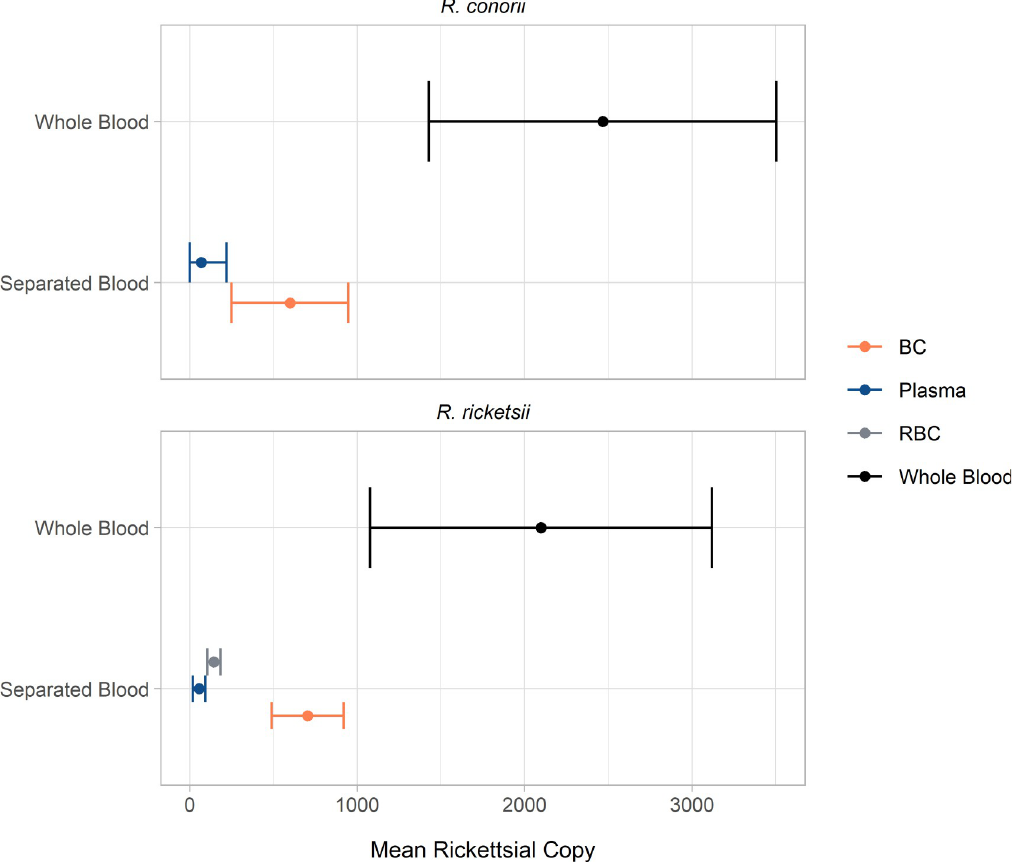
sedimented with Histopaque 1077 gradient. Entire separated blood layers including plasma, BC and RBC (Rri only) were taken for quantification by qPCR. Data represents the averaged total copy number from each blood layer. Whole blood total copy number was averaged from triplicate aliquots of unseparated inoculated whole blood and calculated to 1 mL. All samples were analyzed by PanR8 qPCR in